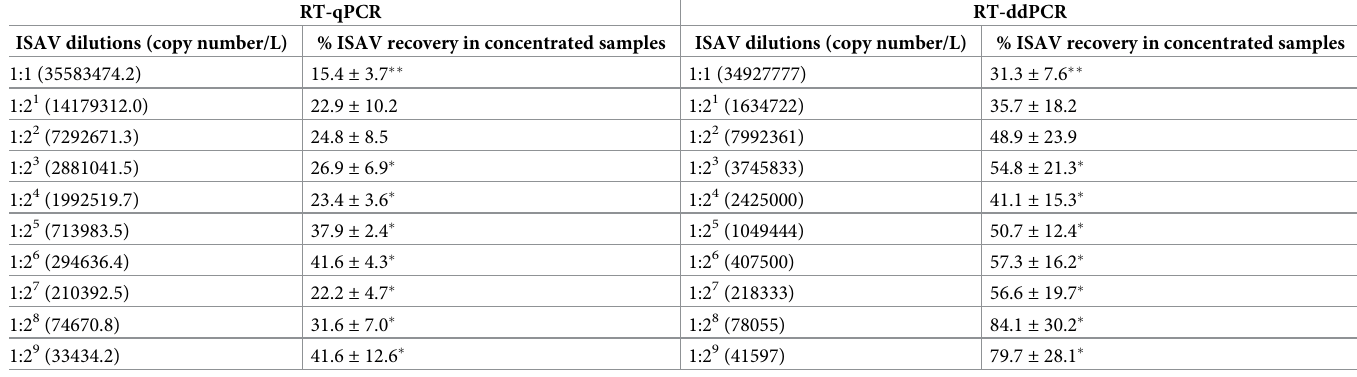
Table 3. Show the difference in ISAV recovery percentages at different virus spiking concentrations for RT-qPCR and RT-ddPCR. Two-fold serial dilutions of ISAV stock sample were used to spike different 1L natural seawater (1 dilution/each), and the spiked seawater samples were concentrated using MF - /buffer 1 concentration method. ISAV recovery percentages (%) and virus copy numbers/L are presented as mean ± standard deviation from four biological replicates. Student t-test was used to compare differences in ISAV recovery between RT-ddPCR and RT-qPCR